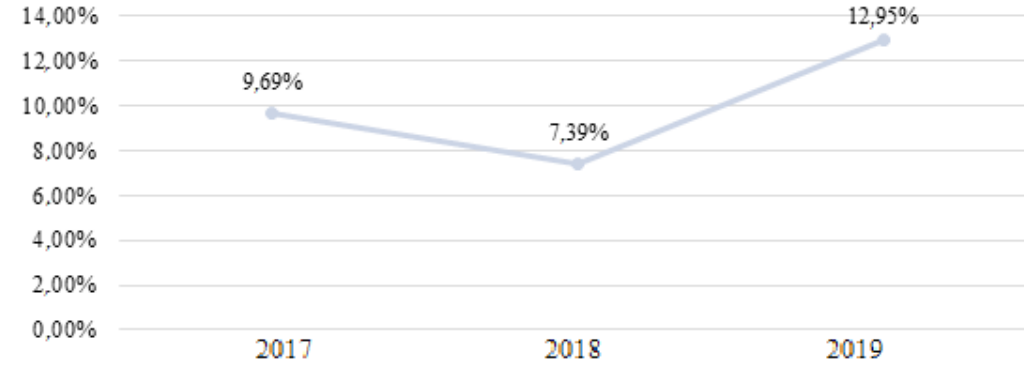
Figure 8. Financial profitability of SMEs financed in the